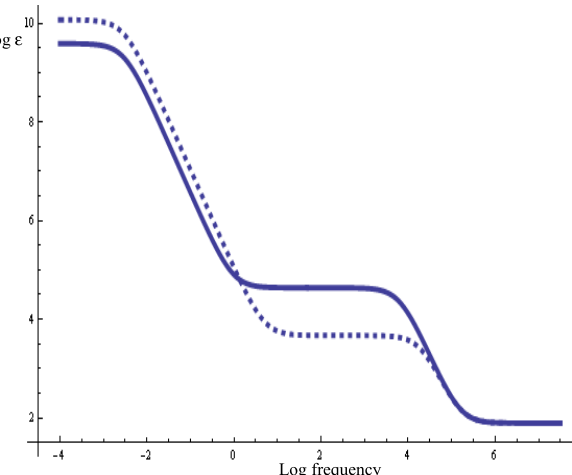
Fig. 1B: Spectra of Impedance magnitude relative to the value at 1 kHz: Δϕ 0 =-150 mV (solid), Δϕ 0 = -75 mV (dashed), Δϕ 0 ~ 0 V (dot-dashed line)